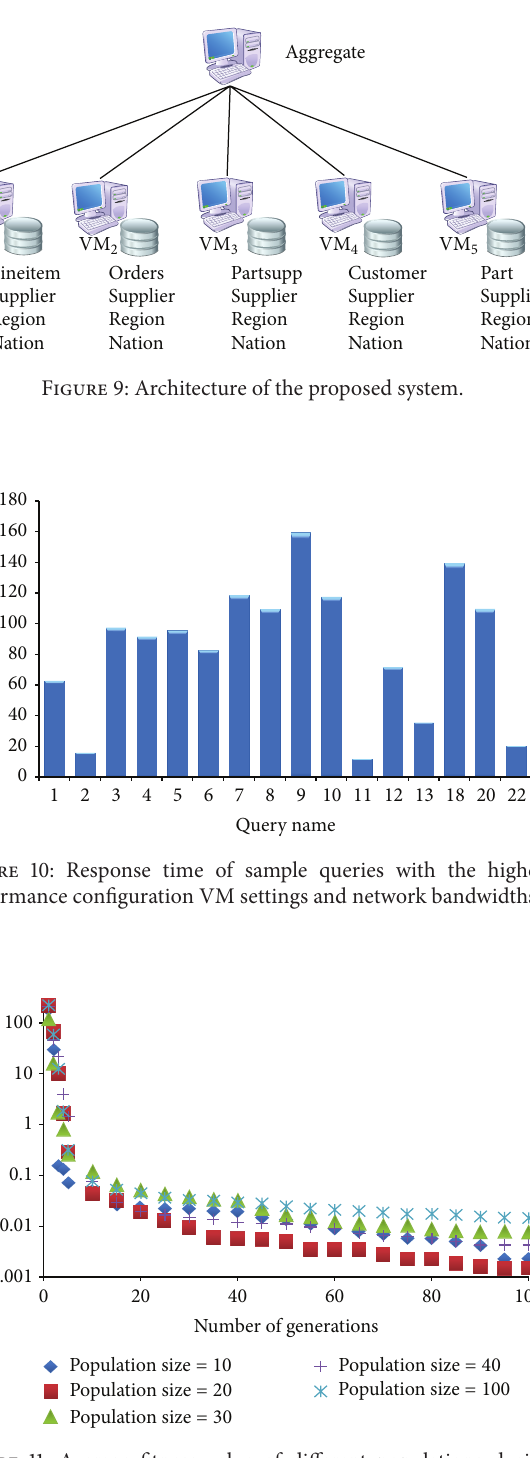
Figure 11: Average fitness value of different populations during generations.